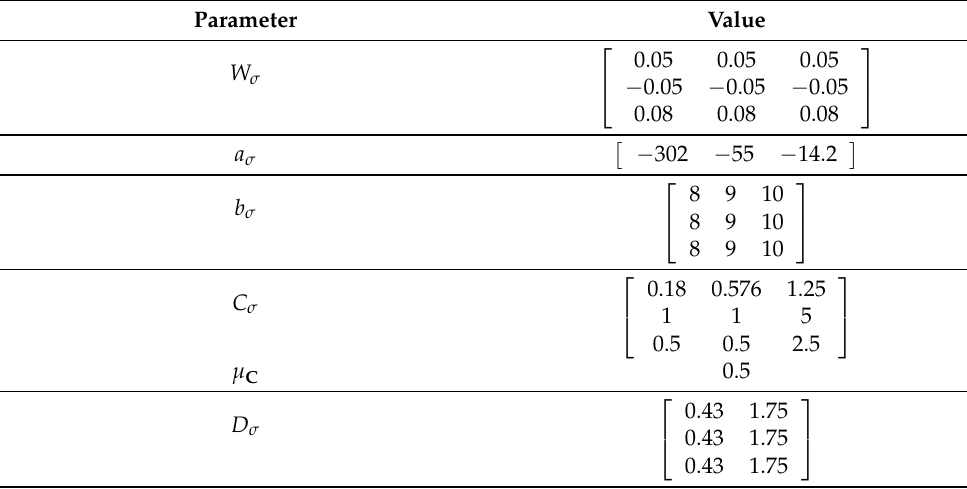
Table 2. Initial values of the parameters of wavenet and PID